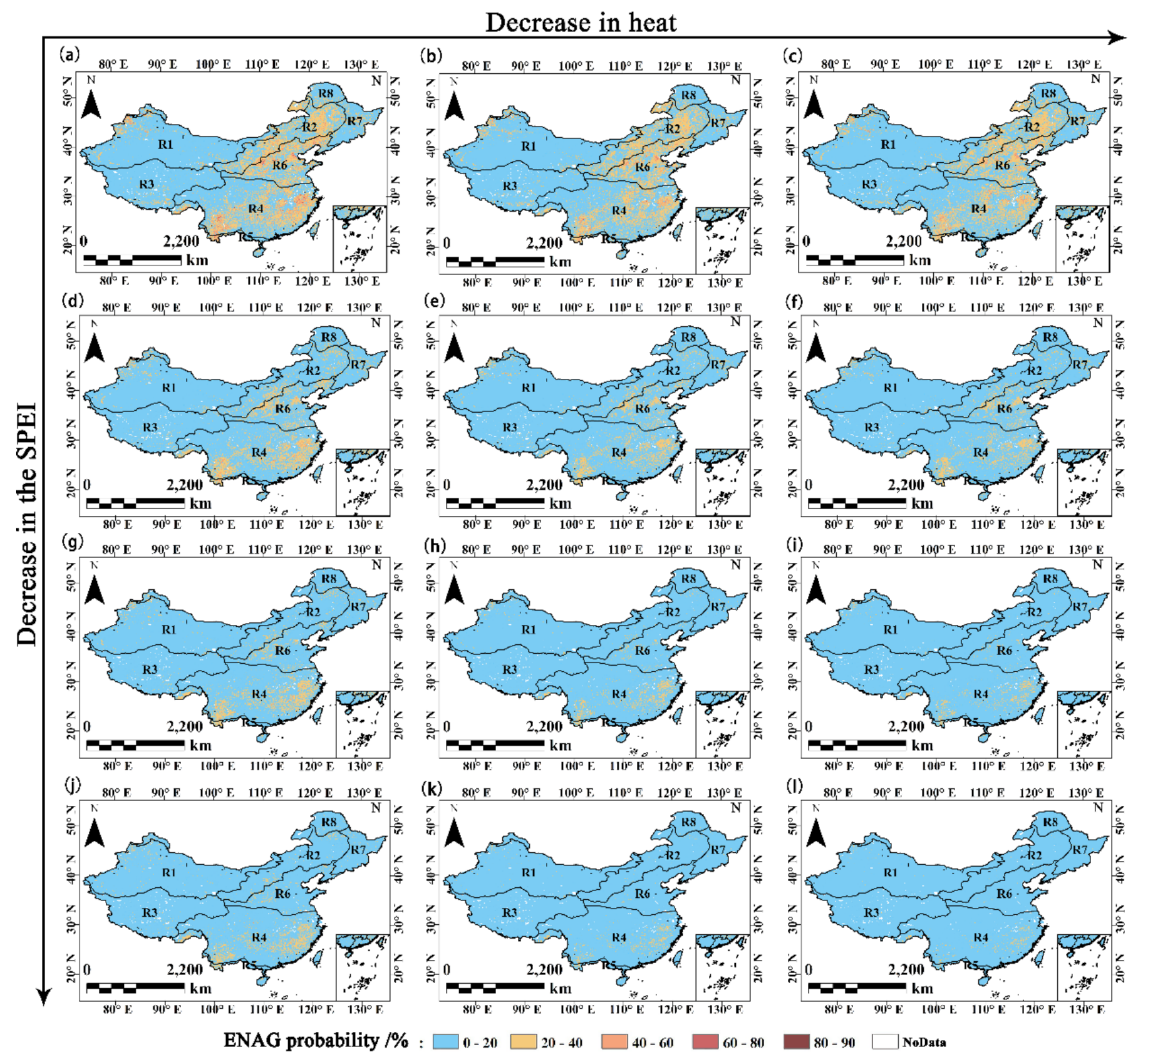
Figure 8. Spatial distributions of ENAG probabilities under different drought levels (SPEI) and different heat intensities. From left to right, the heat intensities decrease from severe to mild, and from top to bottom, the drought levels decrease from extreme to mild (Note: the pixels displayed in white have the same meaning as Figure